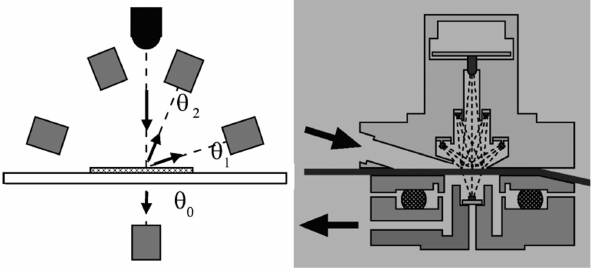
Fig. 1. Schematic of the MAAP. The transmitted light is measured with the photodetector at θ 0 =0 ◦ , and the reflected light with the photodetectors at θ 1 =130 ◦ and θ 2 =165 ◦ . (Figure from: “Aerosol Science and Technology: Evaluation of Multiangle Absorption Pho- tometry for Measuring Aerosol Light Absorption”, 39, 40–51, Copyright 2005, Mount Laurel, NJ, reprinted with